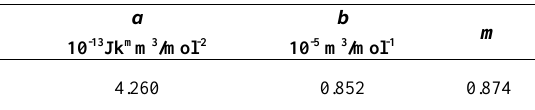
Table 1. Equation - of - state parameters for